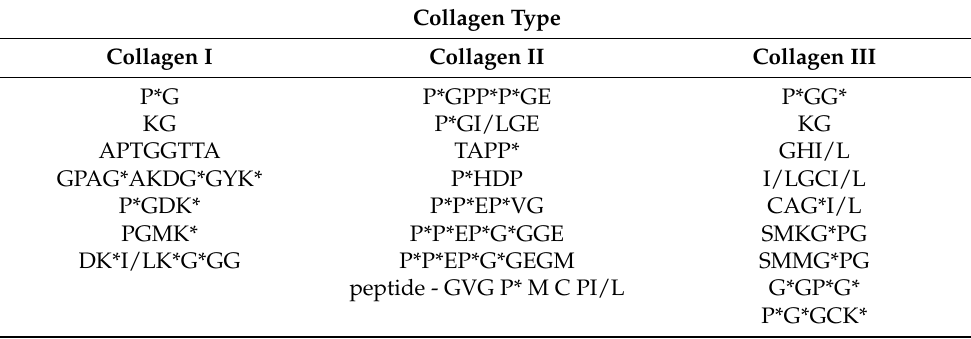
Table 2. Amino acid sequences of collagen fractions isolated from Dosidicus gigas.